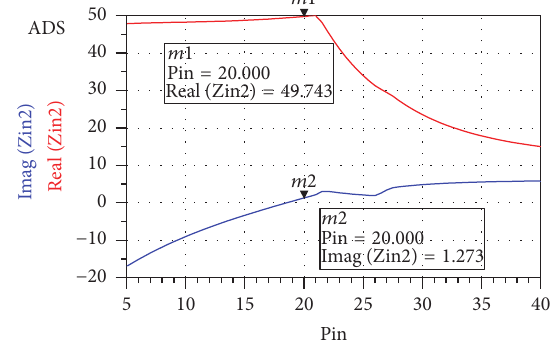
Figure 10: Input impedance of DBS.